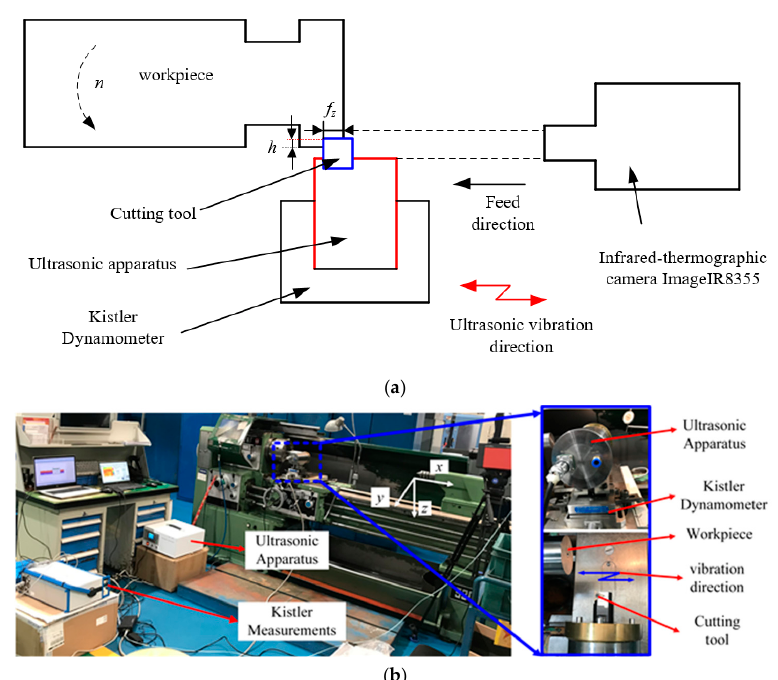
Figure 10. Presentation of the experiment by: ( a ) schematic and ( b ) experimental setup. Table 3. Cutting parameters in UVC experiments.